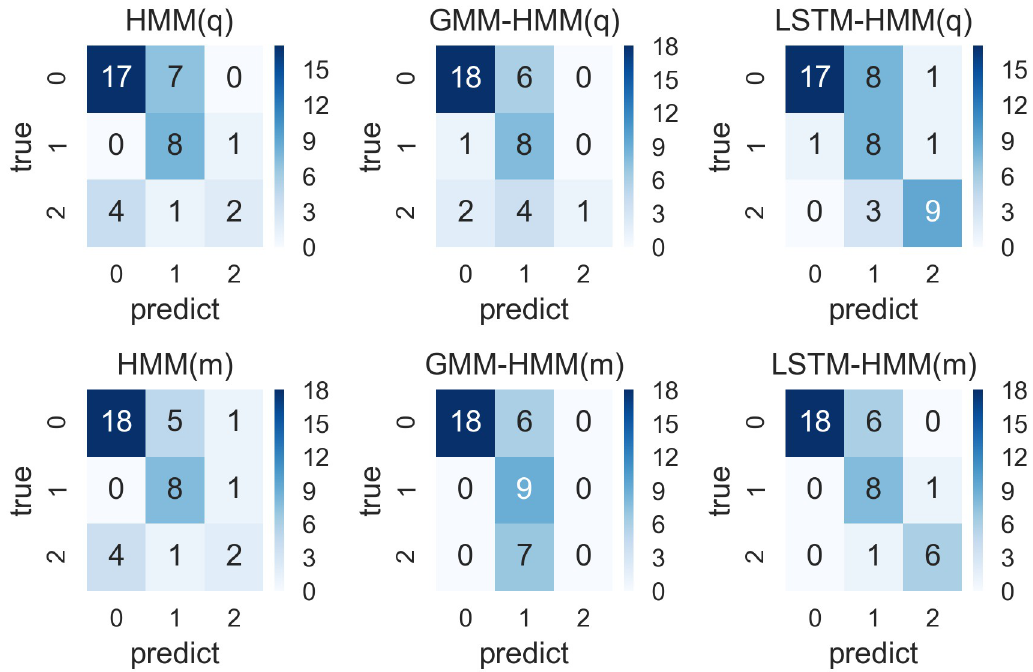
Fig 11. Confusion matrixes for prediction results from HMM, GMM-HMM and LSTM-HMM with monthly or quarterly input and 10-year time window. https://doi.org/10.1371/journal.pone.0269529.g011 HMM(m) with monthly input, GMM-HMM(m) with monthly input and LSTM-HMM(m) with monthly input within 4-year time windows and their confusion matrixes calculated based on the predictions and real values are shown in Fig 8. As we can see from the Fig 8, there are 64 predictions in total, where there are many predic- tions of GDP fluctuation states with value 0 and 2. All these models have precise predictions of GDP fluctuation states with value 0, while GMM-HMM with monthly input and LSTM-HMM with either monthly or quarterly input also have good performance in the prediction of GDP Table 11. Accuracy, kappa and AUC for HMM, GMM-HMM and LSTM-HMM with monthly or quarterly input and 4-year time window. HMM(q)